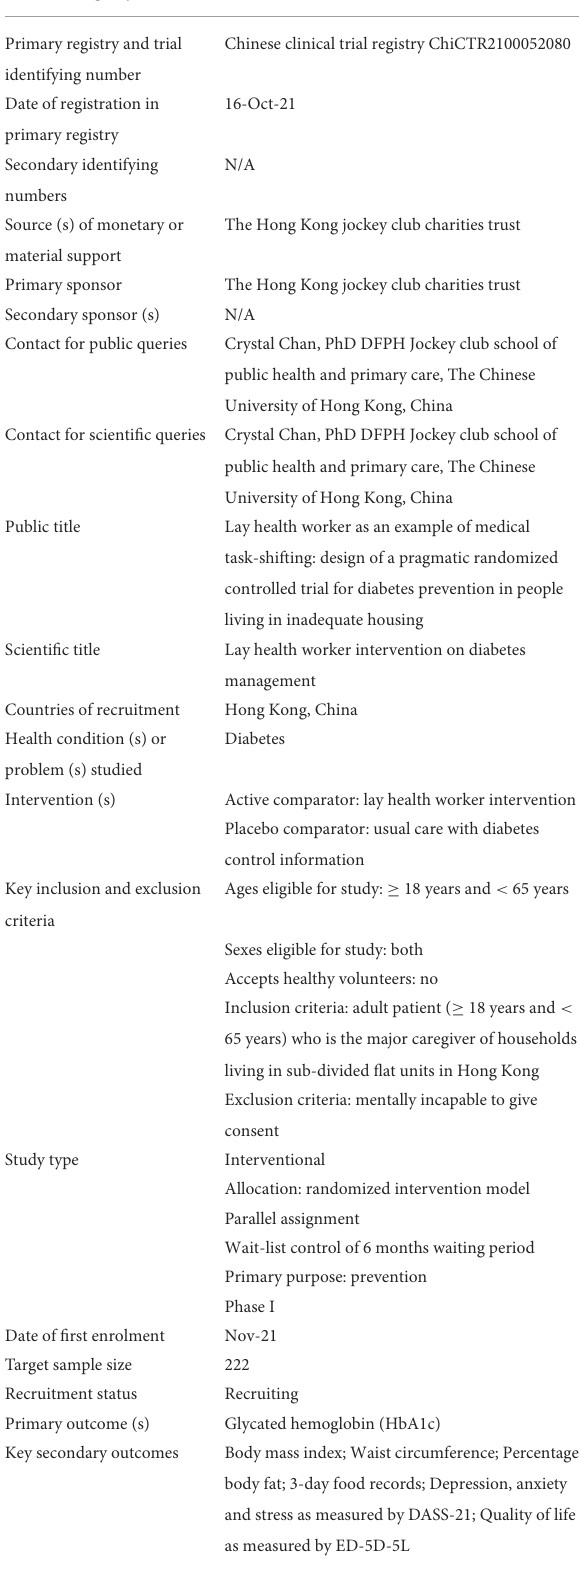
TABLE 1 Minimal data set for trial